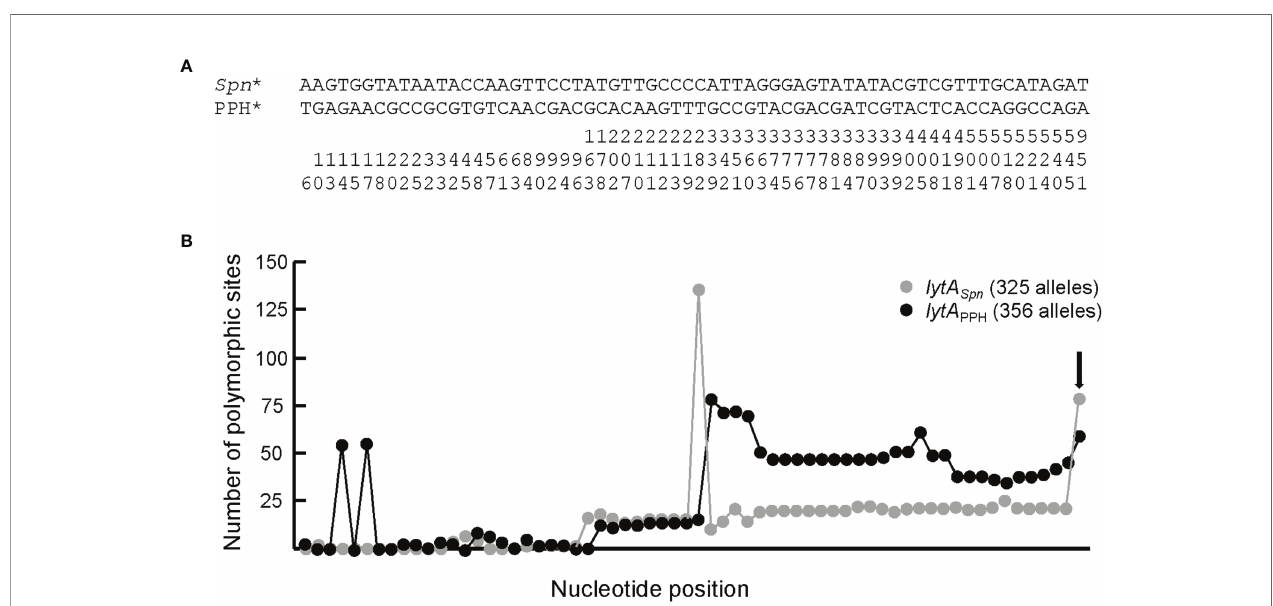
FIGURE 4 | Sequence signatures of lytA Spn * and lytA PPH_090 * alleles. (A) Bacterial and prophage lytA genes of strains harboring PPH090 group phages were aligned and the positions where the bacterial (on one side) and phage (on the other) genes diverged were marked. For simplicity, the highly polymorphic region characteristic of the lytA gene (positions 421 – 480) (Morales et al., 2010) was not included in the alignment. The nucleotide positions (taking 1 as the fi rst nucleotide of the ATG initiation codon) should be read vertically. (B) Distribution of polymorphic sites in bacterial and prophage alleles according to the alignment shown in panel (A) The vertical arrow points to the data at the polymorphic position 951. The total length of the lytA gene is 957